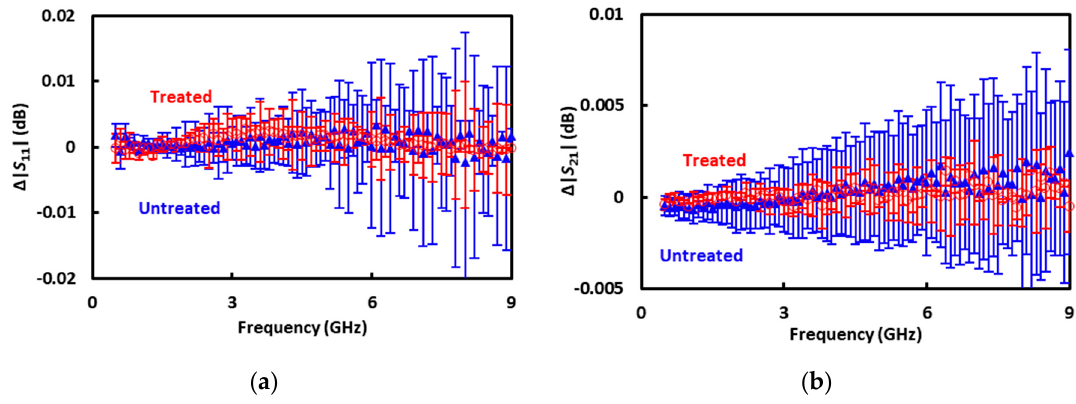
Figure 8. ( a ) ∆ | S 11 | and ( b ) ∆ | S 21 | measured on treated ( Figure 8. ( a ) Δ | S 11 | and ( b ) Δ | S 21 | measured on treated ( ○ ) and untreated ( ▲ ) cells individually.